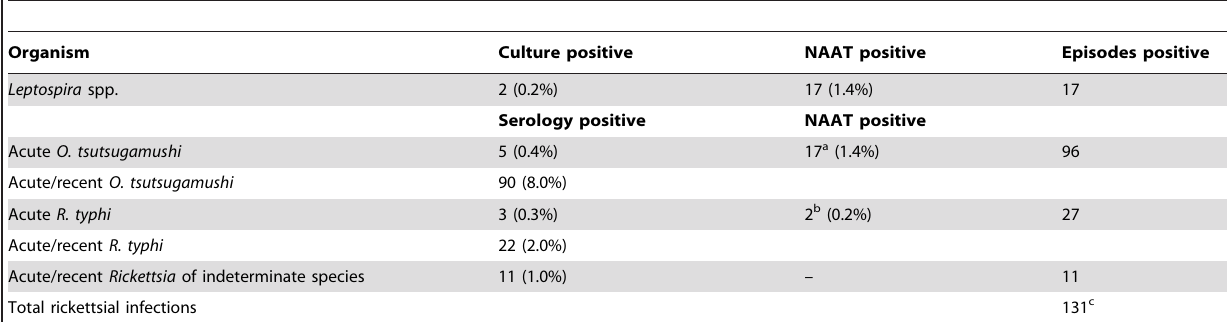
Table 6. Positive results by culture ( n =1068) and NAAT ( n = 1179) for Leptospira spp infections; by serology ( n =1125) and NAAT ( n =1179) for rickettsial infections; and total episodes positive for Leptospira spp and rickettsial infections.